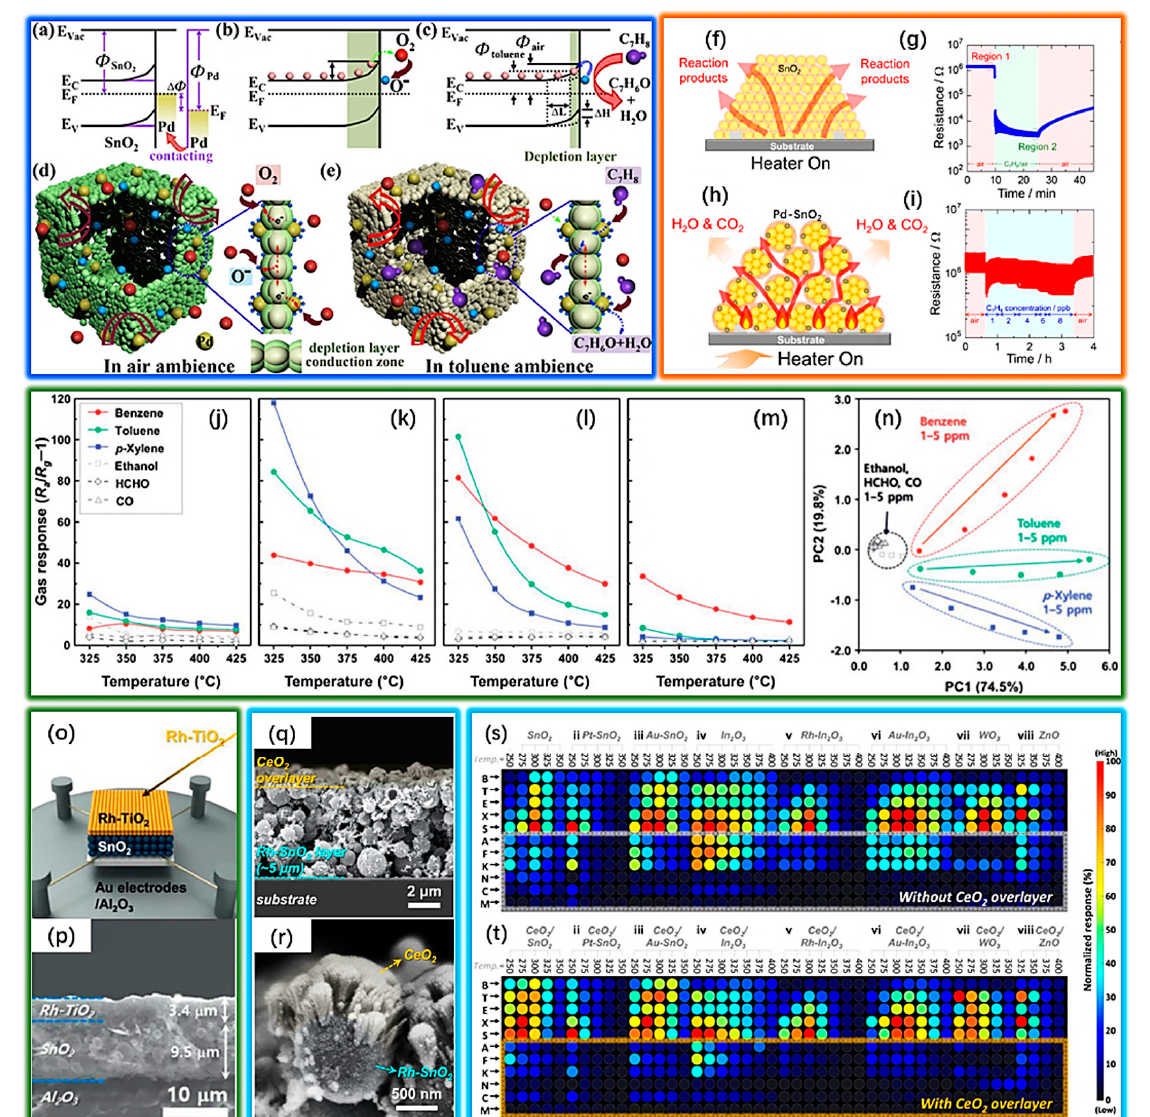
Figure 7. Noble metal modification and gas-sensing performance of SnO 2 . Schematic energy band diagrams of a SnO 2 and Pd contact ( a ) with establishing the contact, with being exposed to ( b ) air and ( c ) toluene ambience, respectively. ( d , e ) Schematic diagrams of possible gas-sensing mechanisms of Pd-loaded SnO 2 porous cages. Schematic diagrams of the gas-diffusion behavior in ( f ) SnO 2 NPs and ( h ) Pd-SnO 2 CNPs. Transient response curve of the SnO 2 NPs microsensor to ( g ) 20 ppm toluene and ( i ) various toluene concentrations at an applied voltage of 1.04 V (~250 °C). Gas-sensing properties of ( j ) pure SnO 2 , ( k ) 0.5Rh-TiO 2 /SnO 2 , ( l ) 1Rh-TiO 2 /SnO 2 , and ( m ) 2Rh-TiO 2 /SnO 2 sensors to the 5 ppm mixed gases (benzene, toluene, p -xylene, ethanol, HCHO, and CO) within the operating temperature range of 325–425 °C. ( n ) PCA plot using the data from 0.5Rh-TiO 2 /SnO 2 , 1Rh-TiO 2 /SnO 2 , and 2Rh-TiO 2 /SnO 2 sensors to demonstrate the discrimination of aromatic BTX compounds over the interferences from ethanol, HCHO, and CO (concentration: 1–5 ppm). ( o ) Schematic diagram of Rh-TiO 2 /SnO 2 sensor. ( p ) Cross-sectional SEM image of Rh-TiO 2 /SnO 2 sensing film. ( q ) Cross-sectional SEM and ( r ) FESEM images of CeO 2 /Rh–SnO 2 film. ( s , t ) Normalized signal intensities of diverse single-layer sensors to 5 ppm analyte gases. Panels ( a – e ): reproduced with permission from Ref. [119], © 2023 Elsevier B.V. Panels ( f – i ): reproduced with permission from Ref. [124], © 2023 American Chemical Society. Panels ( j – p ): reproduced with permission from Ref. [129], © 2023 The Authors. Advanced Science published by Wiley-VCH GmbH. Panels ( q – t ): reproduced with permission from Ref. [130], © 2023, The Author(s).